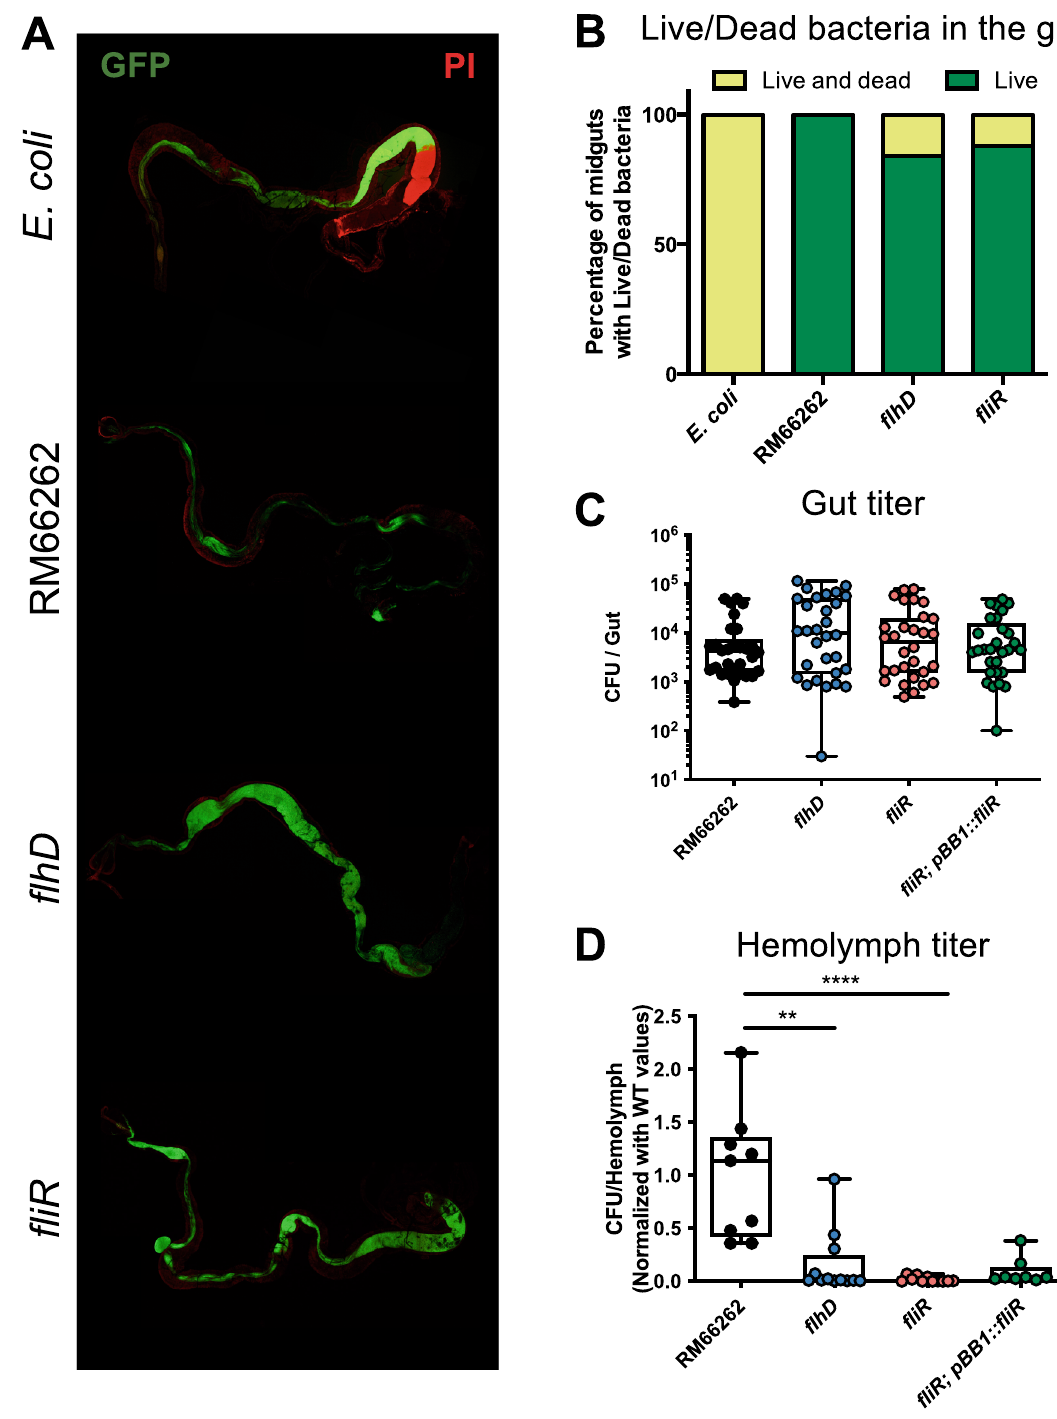
Figure 2. flhD and fliR mutants survive in the Drosophila midgut like wild-type S. marcescens but have decreased ability to cross the epithelial barrier. ( A ) Confocal pictures of w A5001 midguts after ingestion of GFP-expressing bacteria (green) and propidium iodide (PI) (red). Flies were fed on filter pads containing a mix of bacteria (OD 600nm = 10) and PI (50 µg/mL) for 4 h at 25 °C. ( B ) Quantification of w A5001 midguts with live or live and dead bacteria in the RM66262 background. Number of midguts per column = 10–12. ( C ) CFU count of bacteria in the midgut 24 h post-infection. eater −/− mutant flies were fed with bacteria in the RM66262 background (OD 600nm = 0.1) at 25 °C. Each dot in the graph represent one infected midgut. Number of midguts per column = 30. ( D ) CFU count of bacteria in the hemolymph 4 h post-infection. eater −/− mutant flies were orally infected by bacteria in the RM66262 background (OD 600nm = 0.1). Number of dots per column = 9–12. Statistical test was performed using Kruskal–Wallis and Dunn’s post-hoc tests ( C , D ). IPTG (0.5 mM) was added to the fliR rescue strain. Each graph represents one out of three independent experiments that yielded similar results, except for graph ( D ) that represent the pooled data of three independent